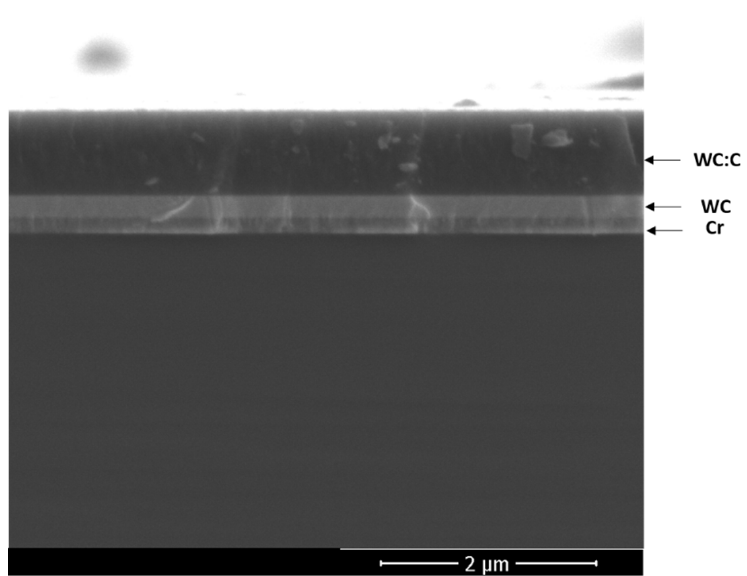
Figure 3. Cross-section SEM image with the coating’s structure of DLC WC:C. From bottom to top the image shows the stainless steel substrate, the bonding layer of Cr, the WC interlayer and the W-doped layer.